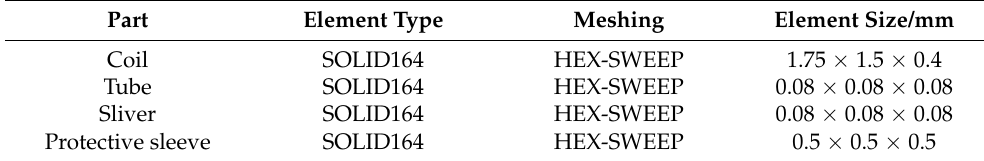
Table 4. Element mesh setting in finite element model.